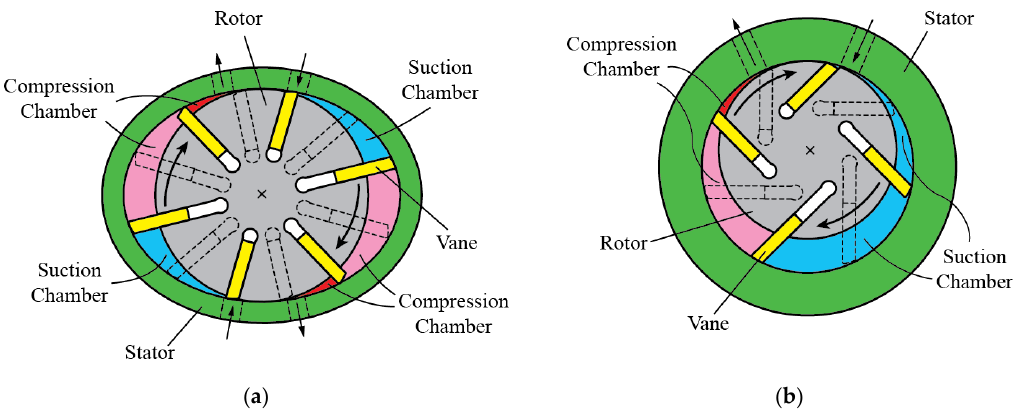
Figure 1. Sliding vane compressor schematics and operating principle: ( a ) elliptical stator with radial vanes; ( b ) cylindrical stator with canted vanes.